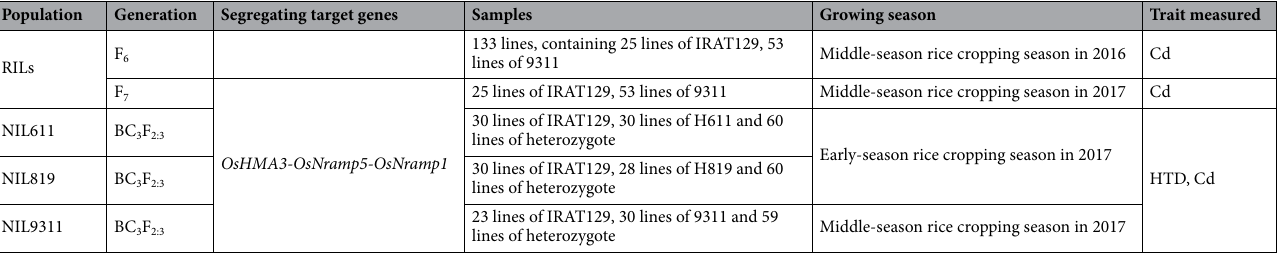
Table 1. Populations used to validate the effect of OsHMA3-OsNramp5-OsNramp1 from IRAT129. The IRAT129, 9311, H611 and H819 presented in the column of samples indicate the haplotype of OsHMA3- OsNramp5-OsNramp1